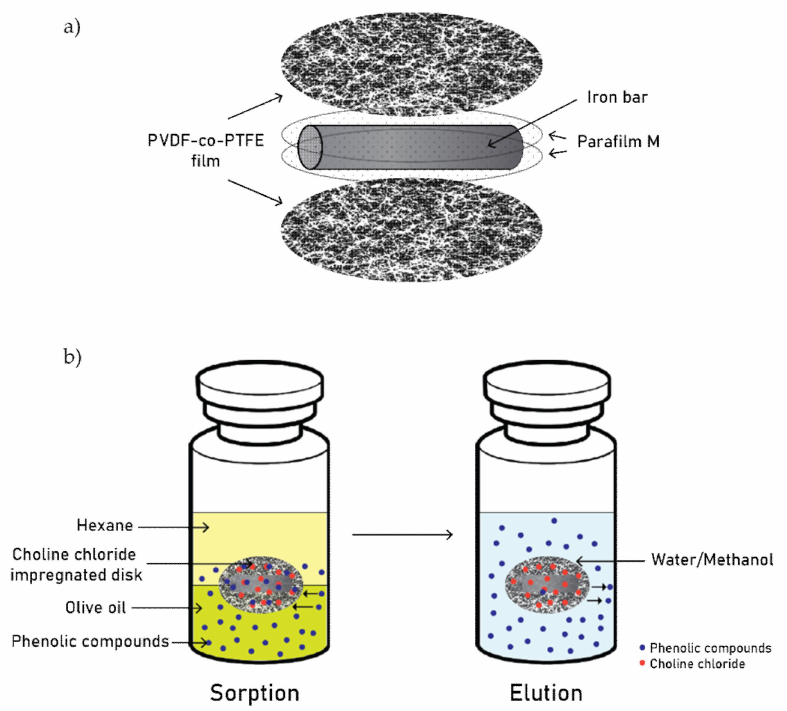
Figure 5. Rotating disk sorptive extraction: disk composition ( a ), sorptive extraction and elution process ( b ). Adapted from Shishov et al.